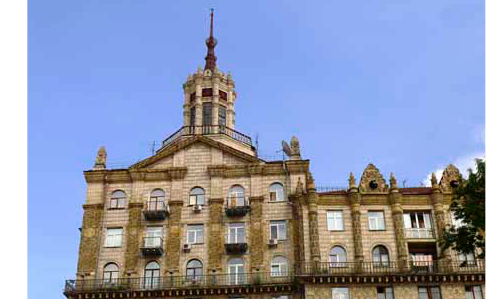
fig. 7. The former lenin Prospect in Minsk. r. Če- fig. 9. The architecture of the Kyiv